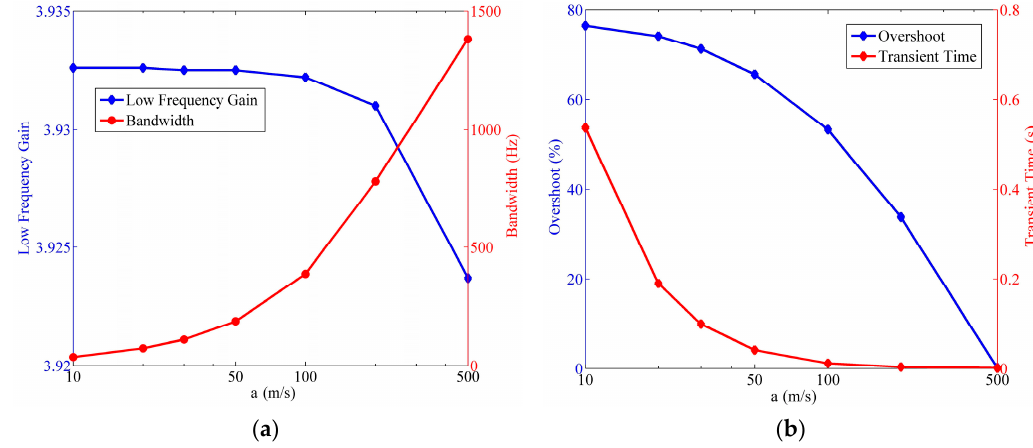
Figure 16. Relationship of the fluidic system indexes versus the wave speed, where R h = 2 × 10 10 Ns/m 5 , R = 25 mm, r = 4 mm. ( a ) Variation of the low frequency gain and the bandwidth; ( b ) variation of the step response overshoot and the transient time.